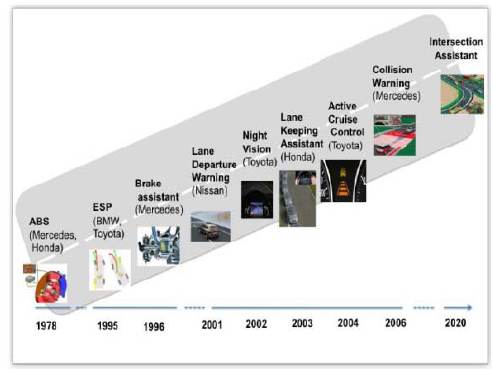
Fig. 9 The development of driver assistance